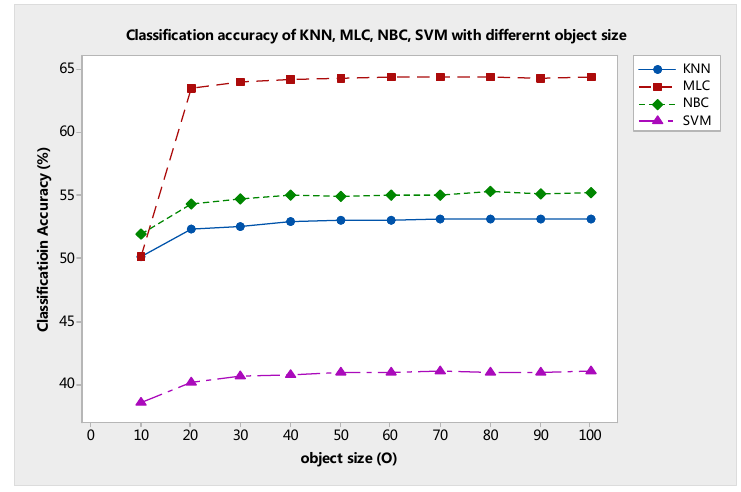
Figure 11. The relationship between OA and object size (O).